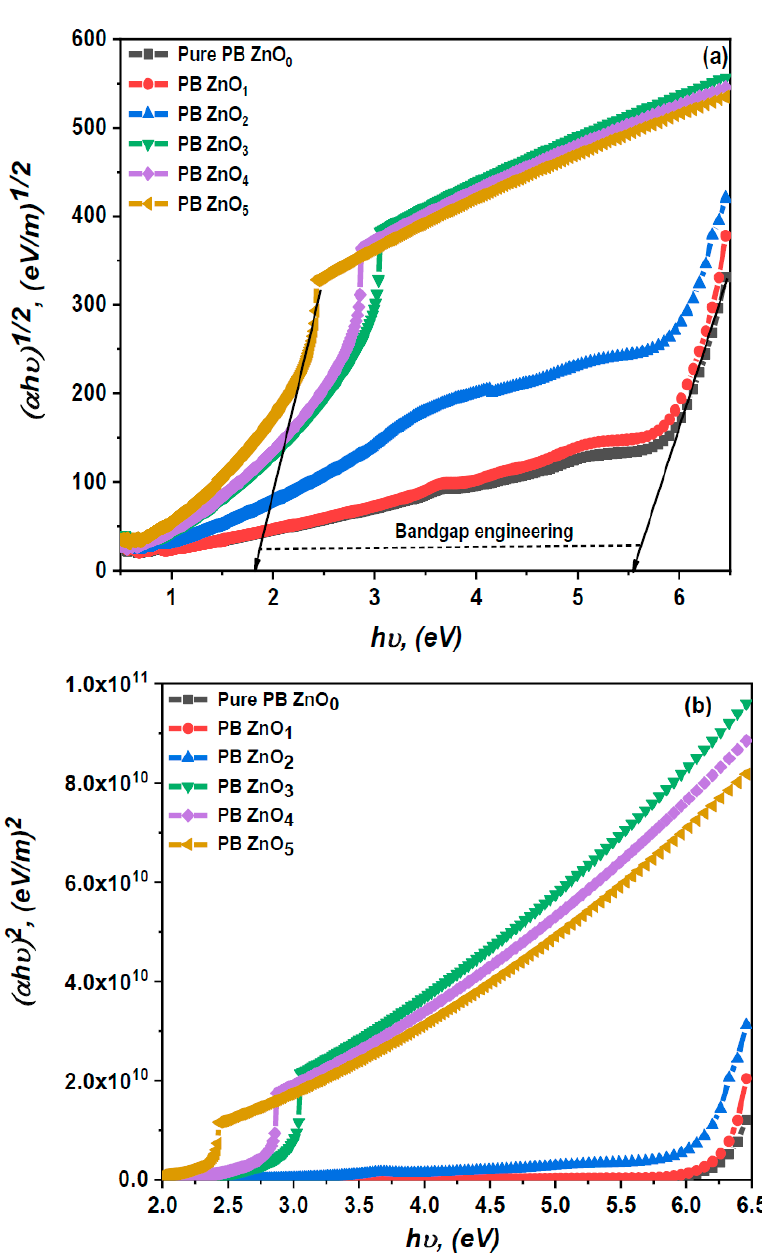
Figure 5. ( a , b ): Plots of ( a ) ( α h ν ) 1/2 and ( b ) ( α h ν ) 2 versus photons energy (h ν ) for the PVA/PVP blend and ZnO polymeric nanocomposite films.